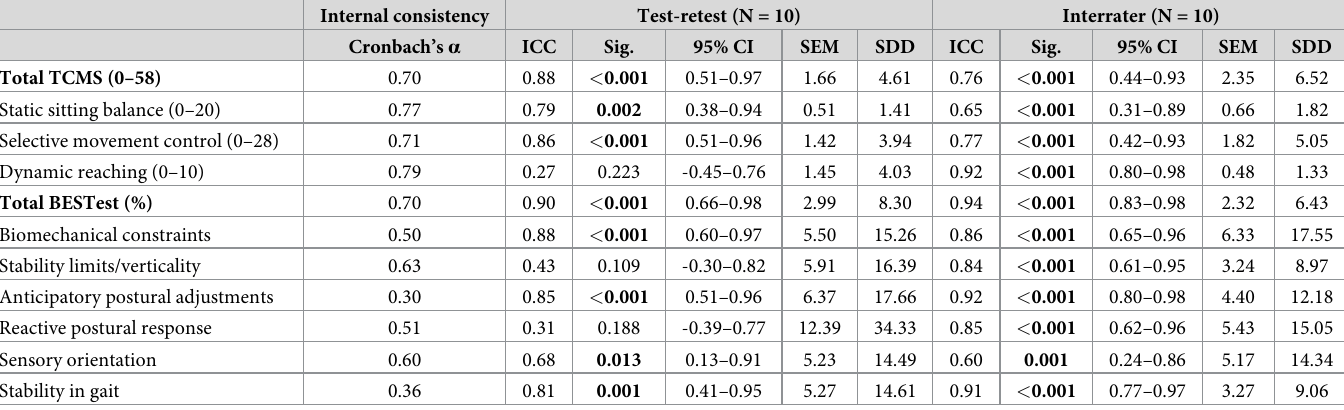
Table 2. Measures for test-retest and interrater reliability and internal consistency of BESTest and TCMS.